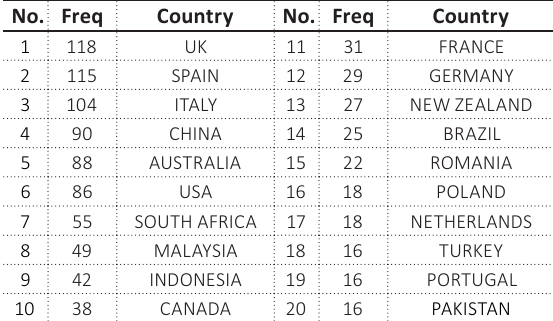
Table 3. Top 20 countries in the number of articles